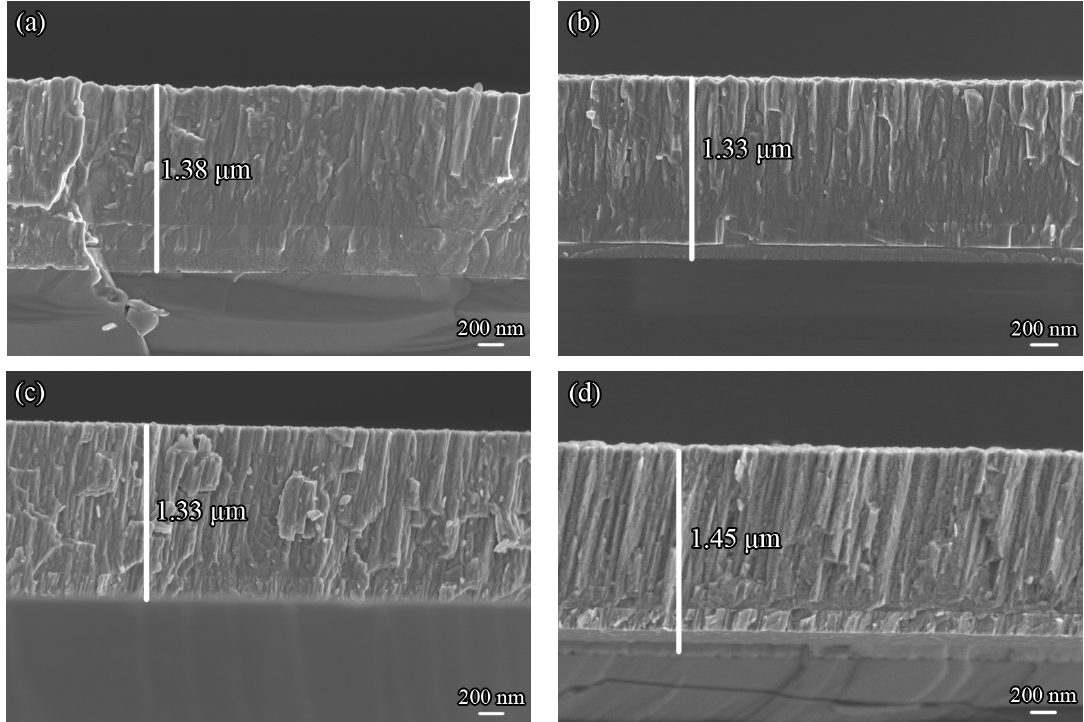
Figure 5. Cross-sectional images of the four CrAlSiN coatings deposited under different Al sputtering power ( a ) 0.6 kW ( b ) 0.8 kW ( c ) 1.0 kW and ( d ) 1.2 kW. power ( a ) 0.6 kW ( b ) 0.8 kW ( c ) 1.0 kW and ( d ) 1.2